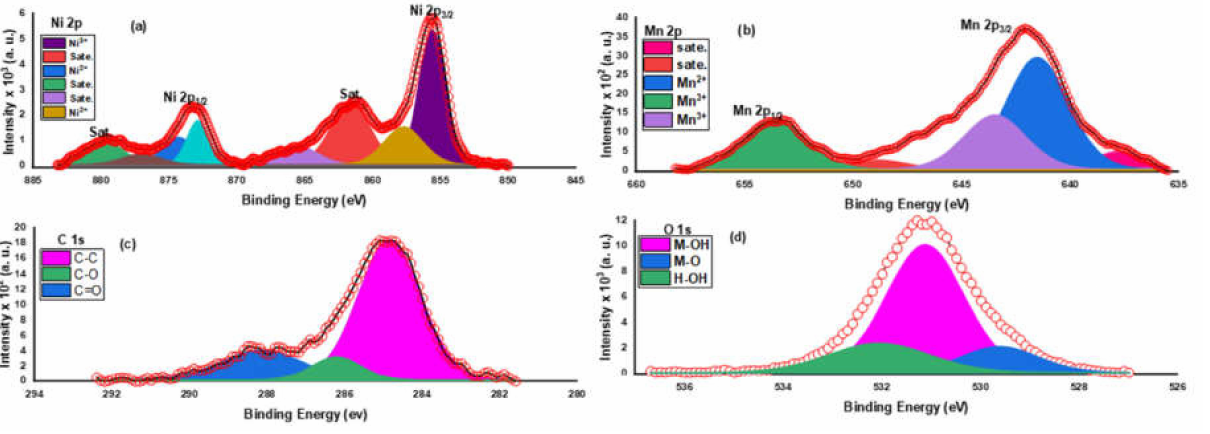
Figure 6. XPS spectra of ( a ) Ni (2p) ( b ) Mn 2p ( c ) C (1s) ( d ) O (1s) spectra for the produced Ni(OH) 2 @Mn 3 O 4